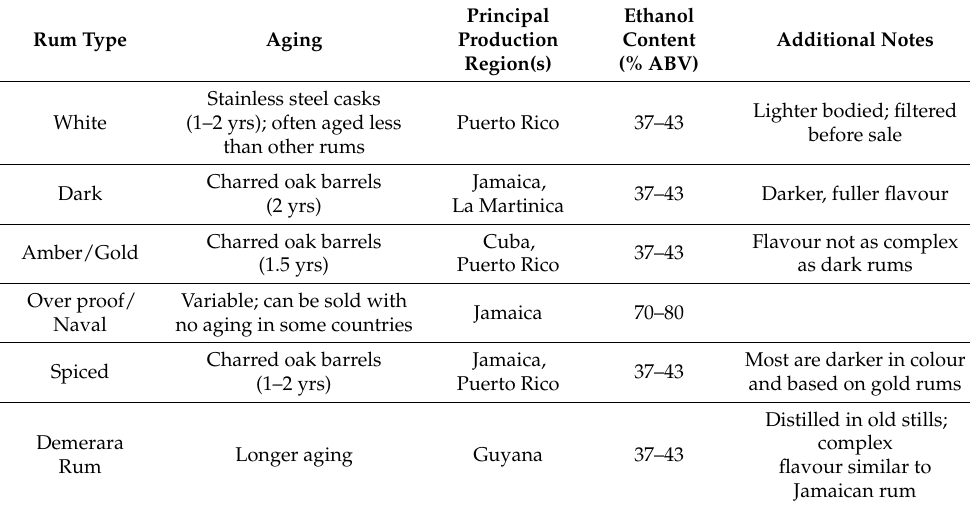
Table 1. A summary of the major types of rum and their